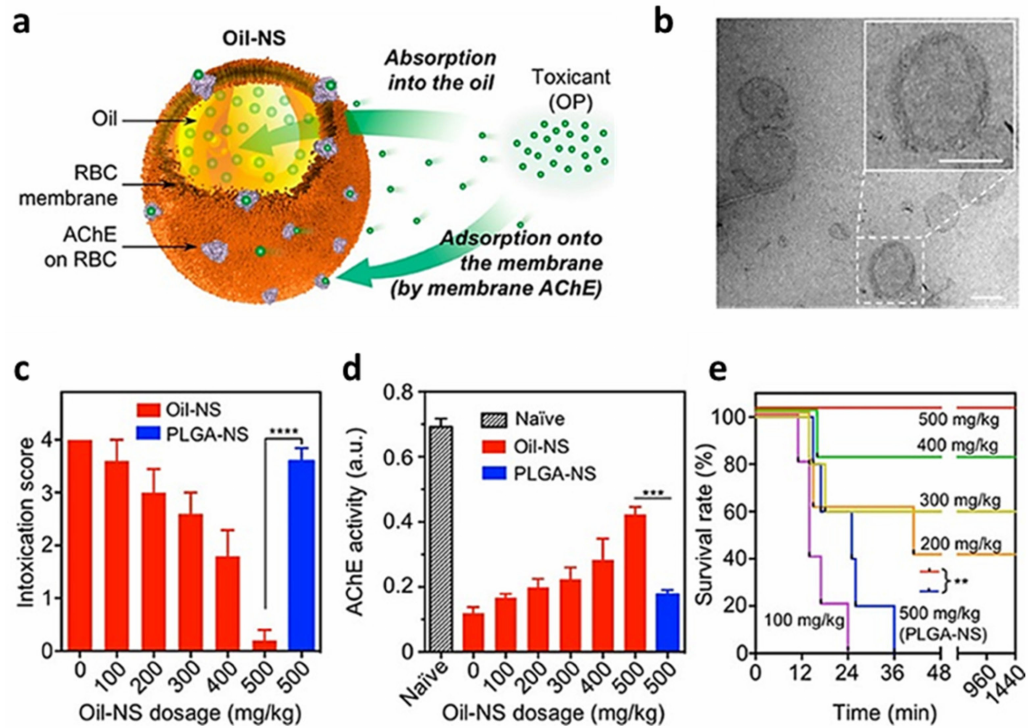
Figure 4. ( a ) Schematic representation of Oil nanospheres (Oli-NS), composed of a small oil droplet stabilized by red blood cells (RBC) derived membrane as detoxifying agent for organophosphate (OP). ( b ) Representative transmission electron microscope image of the spherical core–shell structure of Oil nanospheres. Scale bar = 100 nm. In vivo efficacy of Oil nanospheres against organophos- phates intoxication. Mice were first injected intraperitoneally with oil or PLGA nanoparticles at different doses They were then challenged 2 min later by a single subcutaneous injection of organophosphates at 0.7 mg/kg. ( c ) Intoxication signs of mice were scored at 10 min post-injection. ( d ) Acetylcholinesterase (AChE) activity of blood measured at 10 min post-POX injection. ( e ) Sur- vival rates of mice over 24 h after POX injection. In all studies, n = 5 per group. (** p < 0.01, *** p < 0.001, and **** p < 0.0001). Figure adapted with permission from ACS Nano 2019 , 13 ,